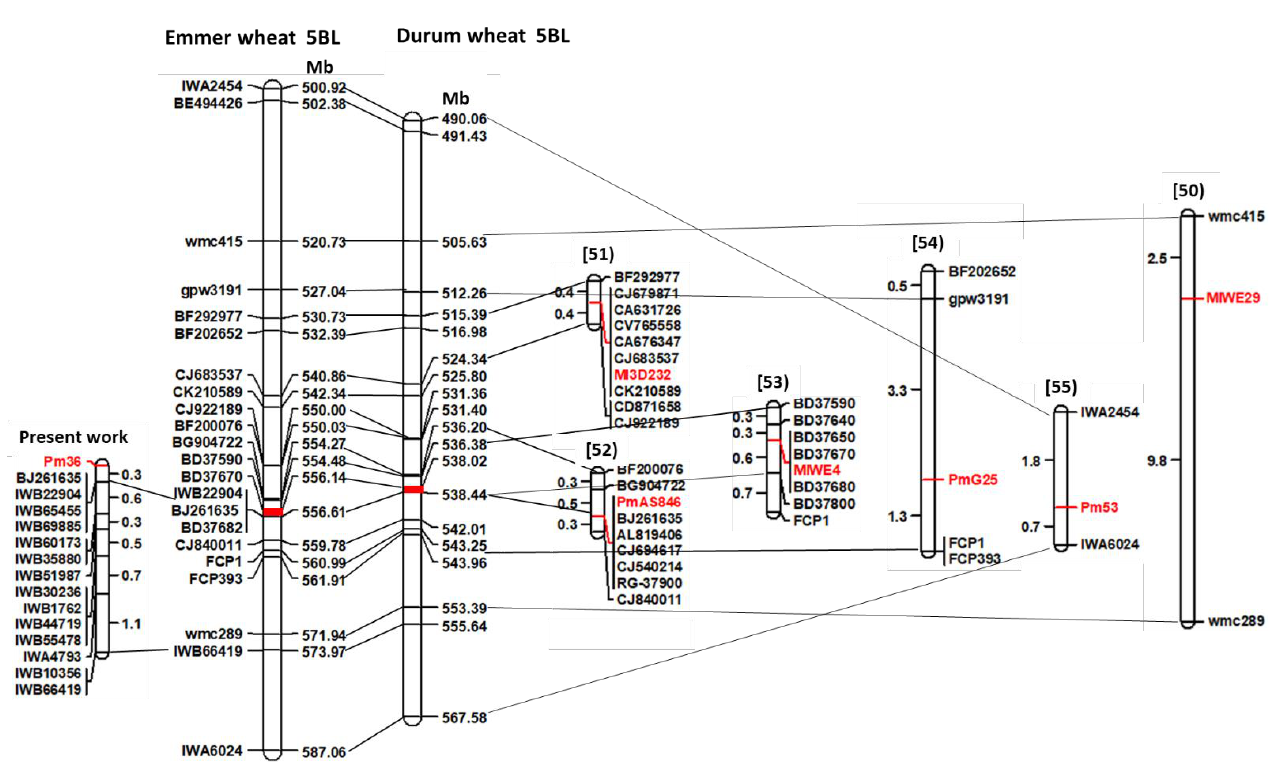
Figure 5. Comparison of the genetic linkage map of Pm36 with those reported for the powdery mildew resistance genes MlWE29 [50], M3D232 [51], PmAS846 [52], MlWE4 [53], PmG25 [54], Pm53 [55] located on the 5BL chromosome arm. Marker sequences of each map were physically located (in Mb) on the wild emmer Zavitan reference genome v2.0 [46] and on the Svevo reference genome v1.0 [45] to make possible the comparison of genetic maps constructed with different molecular markers. Marker loci are listed to the left of the emmer and durum physical maps and Mb distances are shown to the right. The partial comparison maps show the references above the maps, the marker loci on the right and the genetic distance in centiMorgan (cM) on the left. The lines connect the flanking markers of each map with their physical location (in Mb) on the emmer and durum genomes. The red blocks indicate the Pm36 genomic